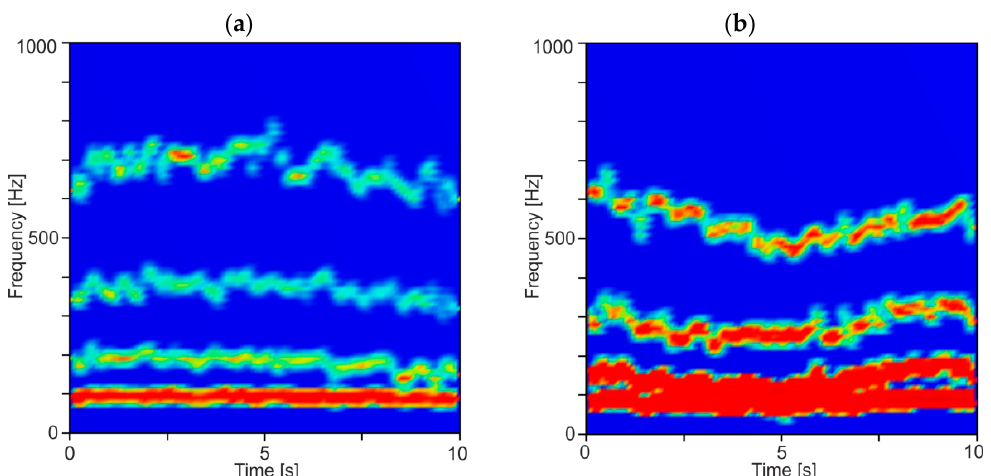
Figure 10. Time–frequency spectrogram for: ( a ) stable ( a p = 0.5 mm, n = 6000 rpm) and ( b ) unstable cutting ( a p = 1.5 mm, n = 6000 rpm).